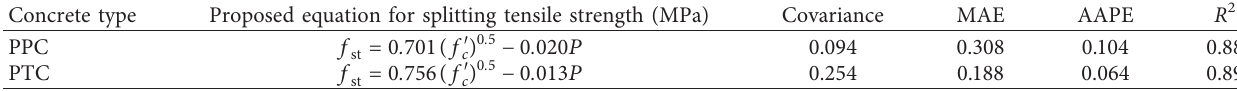
Table 4: Equation for splitting tensile strength as a function of compressive strength and plastic aggregate percentages. Concrete type